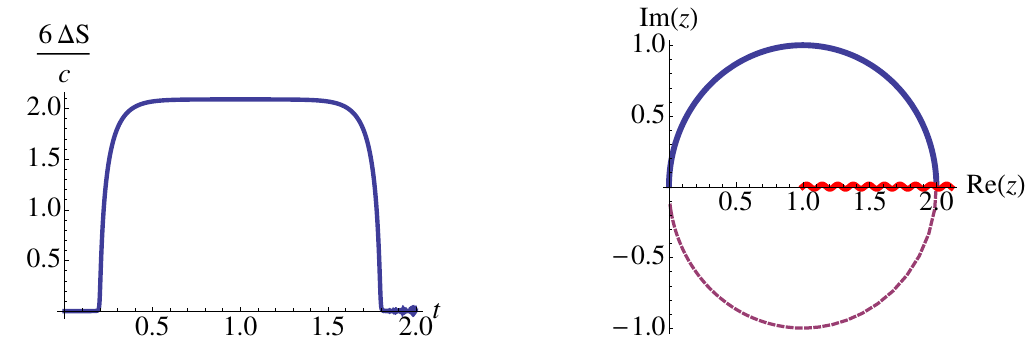
Figure 1 . Left: the change in the entanglement entropy as a function of time at (cid:12) = 0 : 5 with ‘ 1 = 0 : 2, ‘ 2 = 1 : 8, following a quench by an operator with (cid:1) O =c = 0 : 01 and quench width (cid:15) = 0 : 005. Right: the cross-ratio z traverses clockwise around the branch point at z = 1, crossing the branch cut, and moving to the next sheet when the excitation enters the light cone of the endpoint at x = ‘ 1